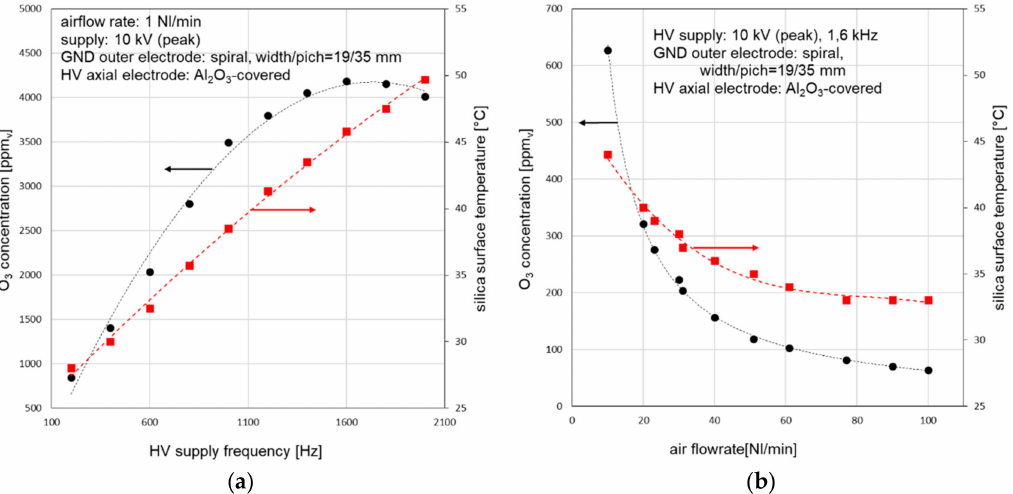
Figure 6. Variations of O 3 concentration and temperature in the volume DBD OG fitted with Al 2 O 3 -covered internal and 19 / 35mm width / pitch spiral outer Cu electrode supplied using 10 kV sinusoidal HV power supply: ( a ) at 1 Nl / min airflow, ( b ) at moderate airflow and 1.6 kHz HV power